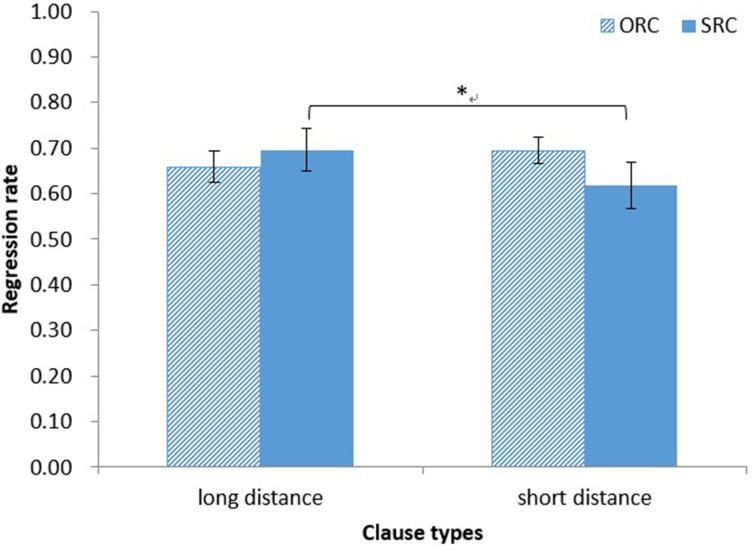
Chinese group: regression rate for EVs in RCs. *p < 0.05.